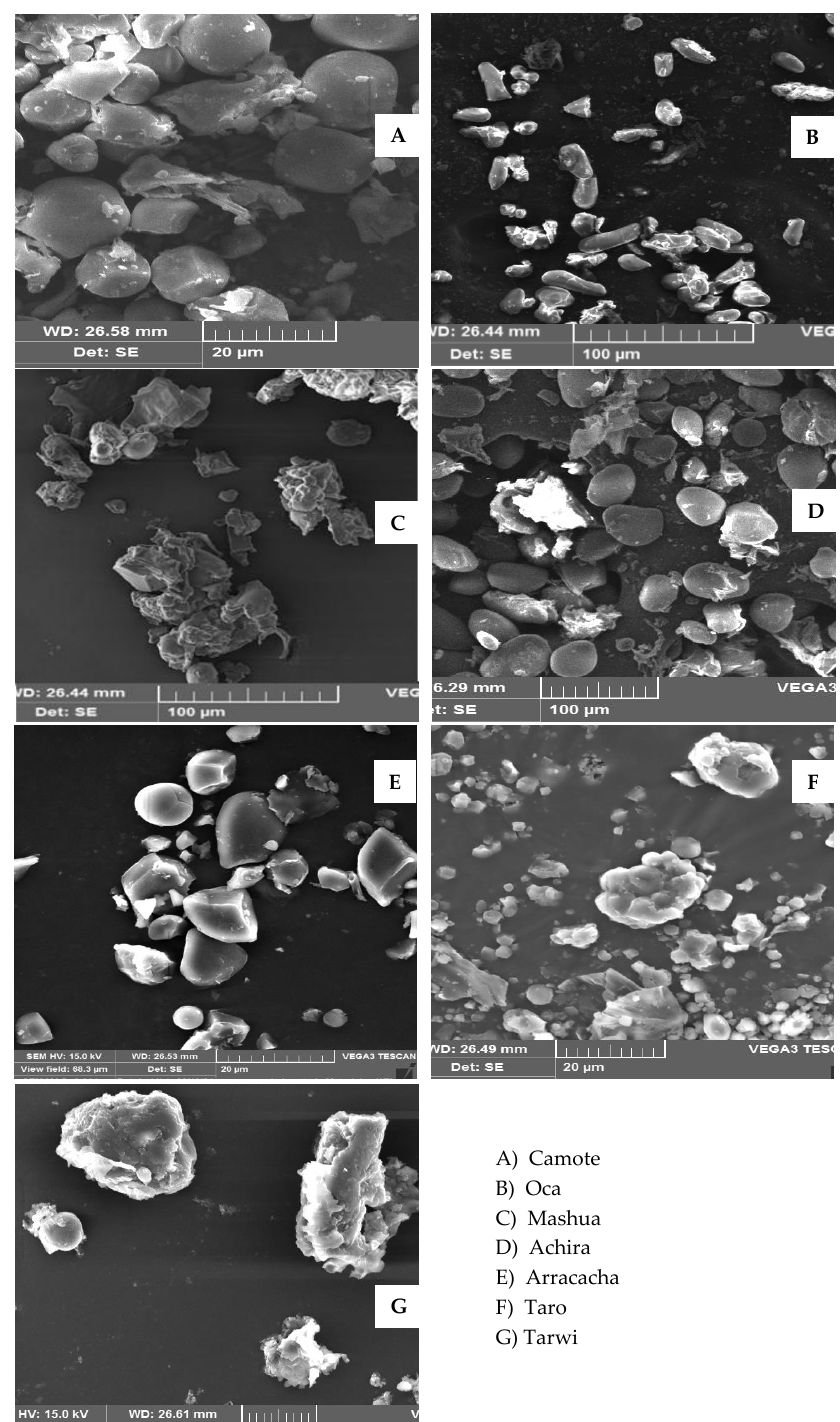
Figure 2. Micrographs of andean crops flours with 546 X magnification